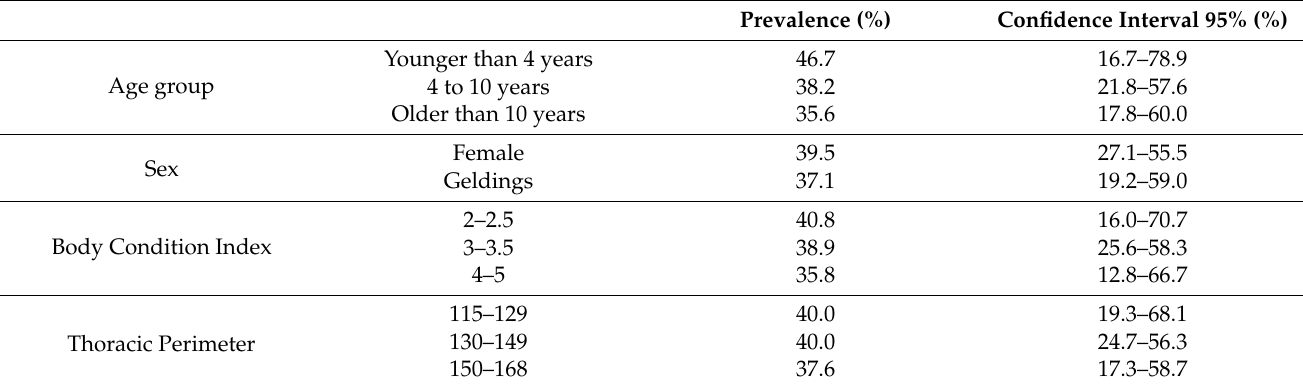
Table 4. Prevalence of parasitism observed in the population during the study period, per parameter.